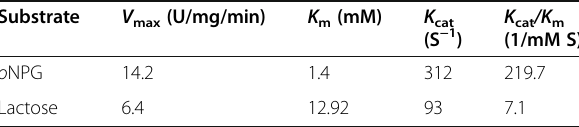
Enzyme activity for the selected substrates was assessed under standard conditions using 0.5 – 25mM of O-nitrophenyl b- D -galactopyranoside or 20 – 360mM of lactose in 50mM sodium phosphate buffer (pH7.8) at 40°C for 10 min. For lactose-hydrolyzing activity, glucose oxidase was used to determine the specific activity. The K m and V max values were calculated by a Lineweaver-Burk